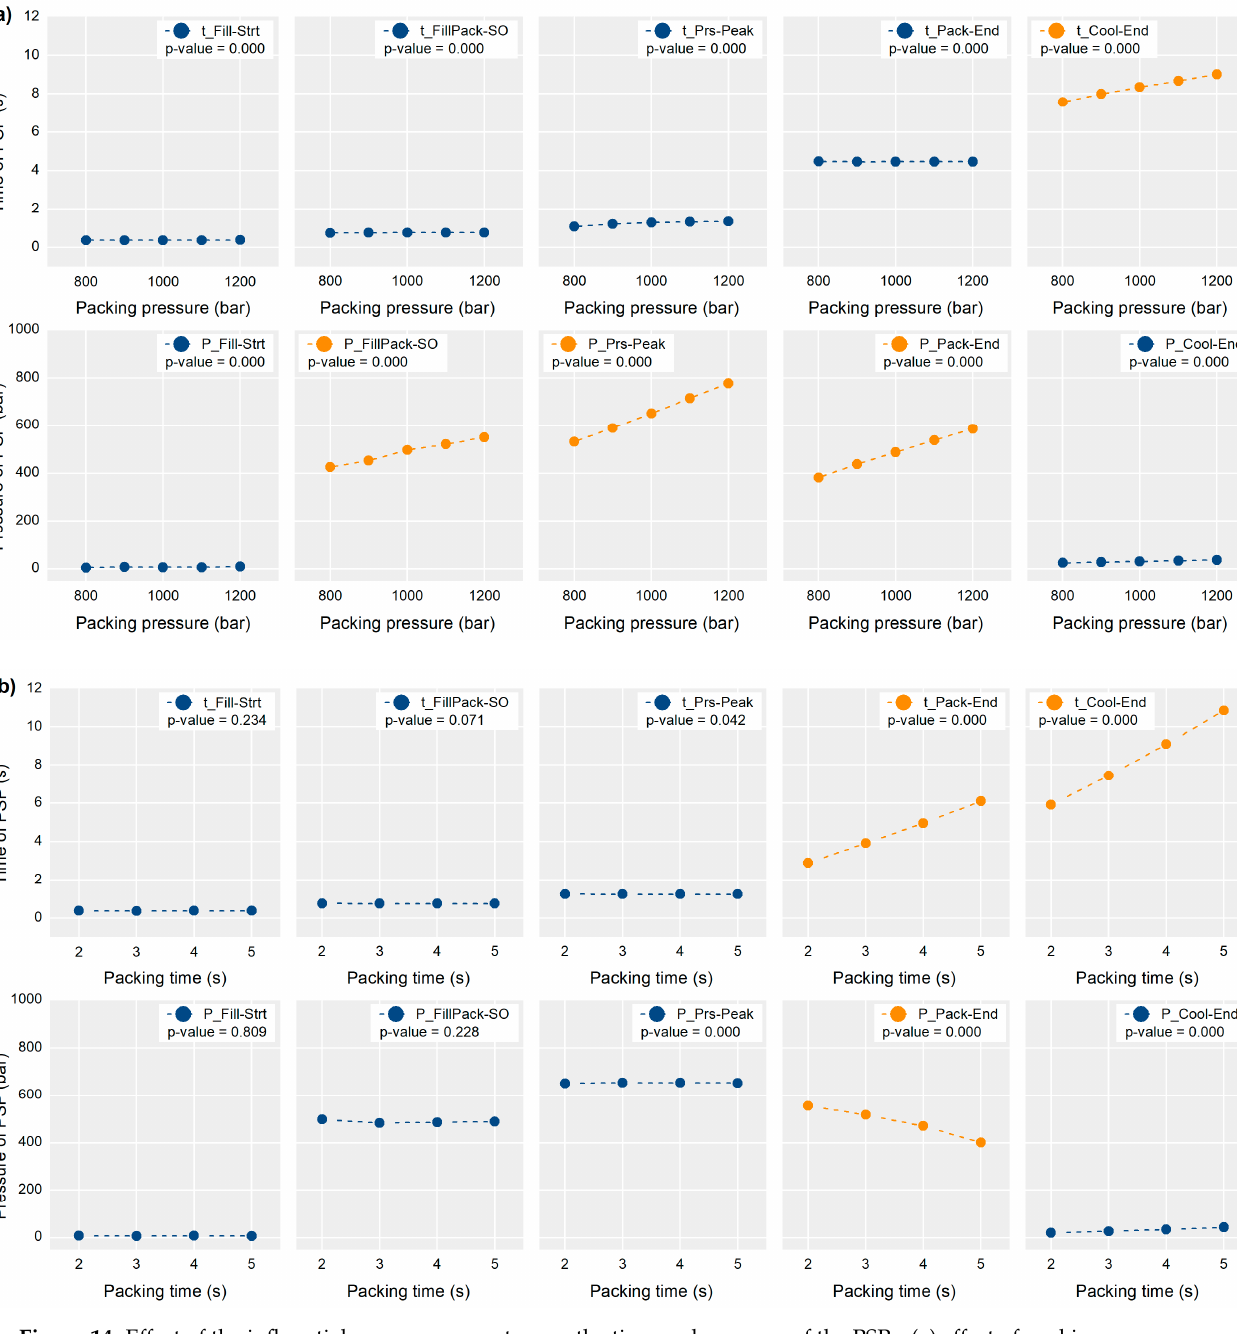
Figure 14. Effect of the influential process parameters on the time and pressure of the PSPs, ( a ) effect of packing pressure on the PSPs, and ( b ) effect of packing time on the PSPs.